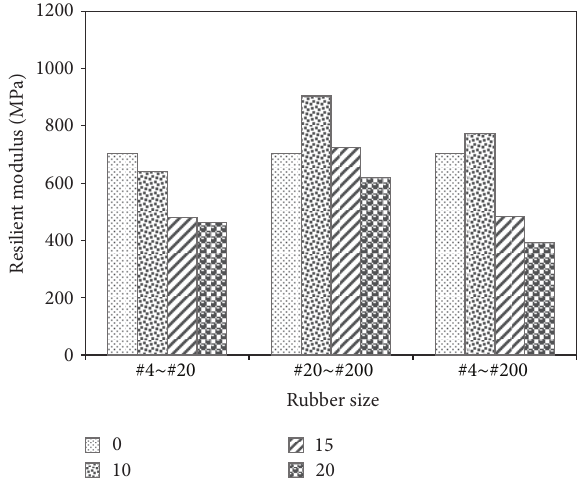
Figure 11: Effect of crumb rubber size on resilient modulus.